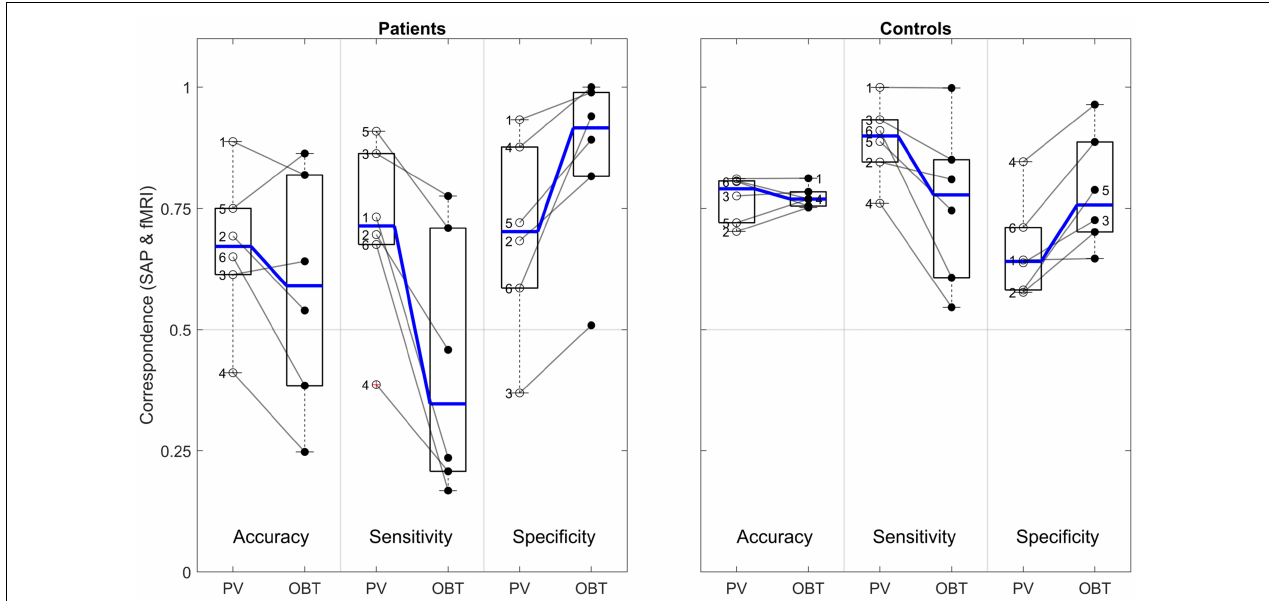
FIGURE 5 | Difference in atlas-based correspondence measures (V1–V3-pooled) for PV and OBT in patients (left panel) and controls (right panel). Subpanels delineated by transparent gray lines encompass the boxplots for PV (left) and OBT (right) for accuracy, sensitivity and specificity, respectively. Thick horizontal blue lines within the box plot represent the median of the measure and the blue lines connecting the PV and OBT box plots indicates the slope of median difference between them. Participant-specific correspondence measures, superimposed on the box plots (PV – open dots and OBT – closed black dots) are connected by a line to indicate the slope of the difference. Numbers 1–4 in the patients’ panel represents the glaucoma participants GL1–GL4 and 5 and 6 represent RP1 and RP2. In the controls panel, 1–6 represents HC1–HC6,